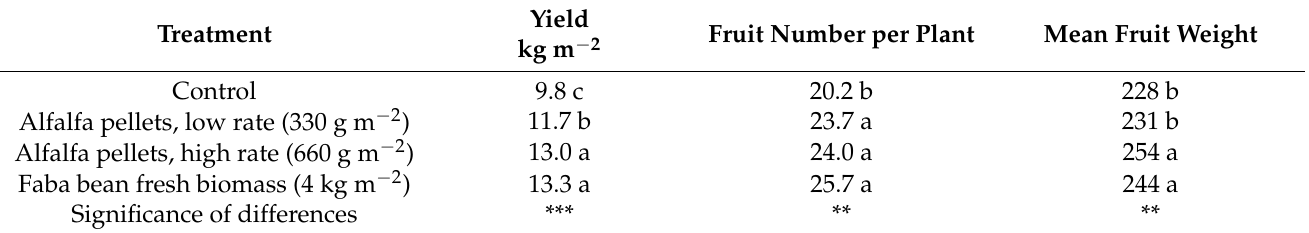
Table 2. The impact of different organic fertilization treatments on organic greenhouse tomato yield components.